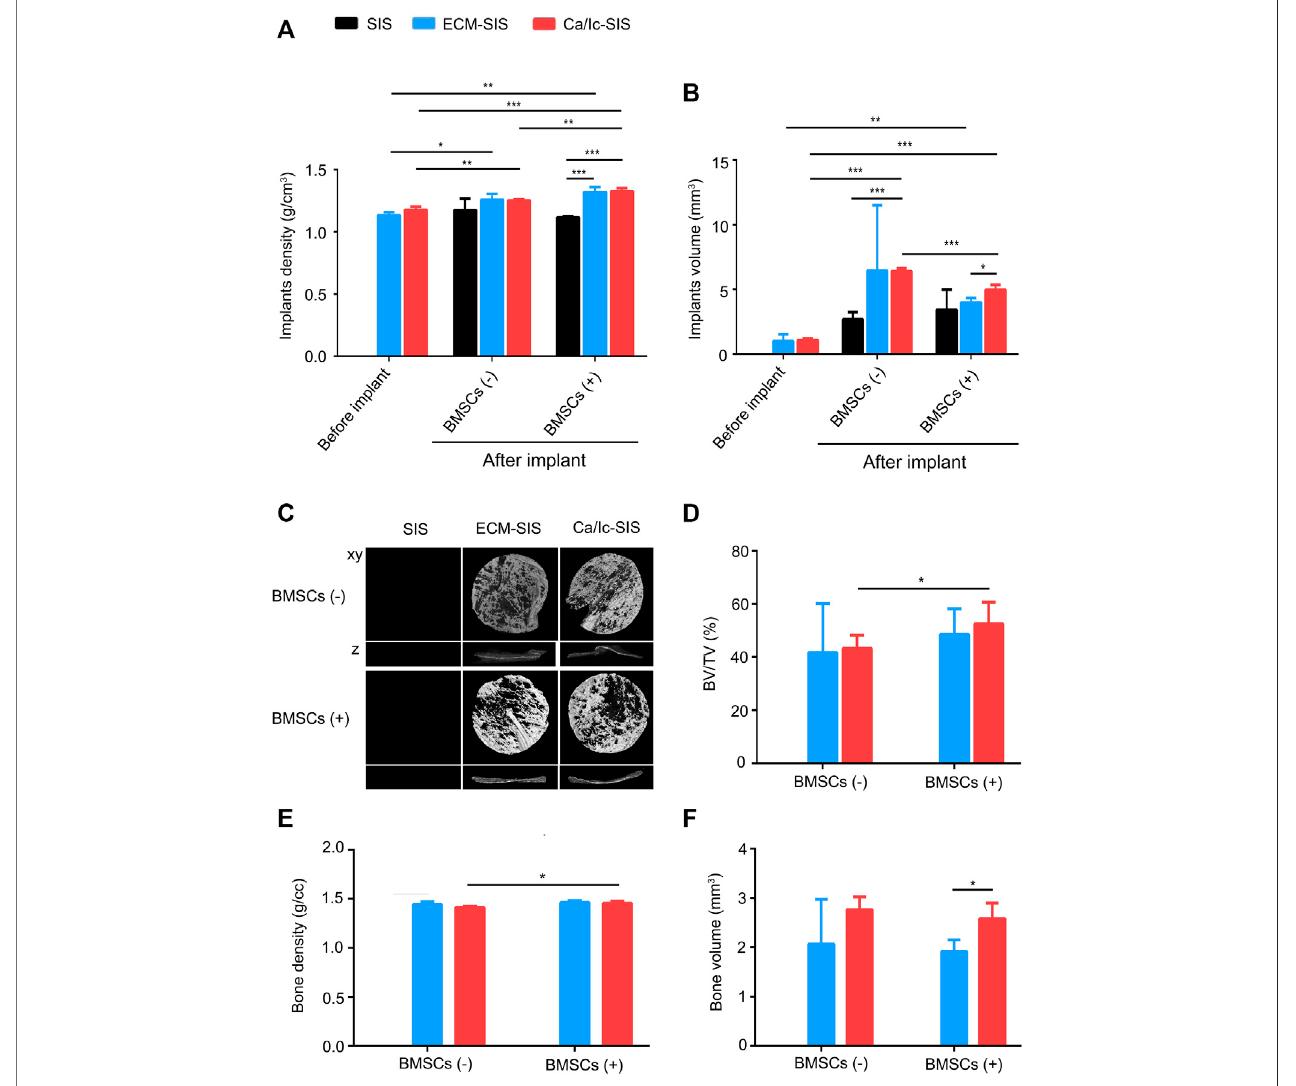
FIGURE 3 | Micro-CT evaluation and ectopic bone formation induced by ECM-SIS and Ca/Ic-SIS (with or without BMSCs) 8 weeks after subcutaneous implantation in mice. The density (A) and volume (B) of the scaffolds before or after the implantation were analyzed by micro-CT. (C) Representative 3D reconstructed micro-CT images 8 weeks after the implantation. The new bone formation ratio (D) , regenerated bone density (E) , and bone volume in the region of interest (ROI) (F) of each group were calculated based on 3D reconstructed images using Mimics (Materialise). Mean +S.D. ( n (cid:1) 3).*, p < 0.05, **, p < 0.01, and ***, p < 0.001.